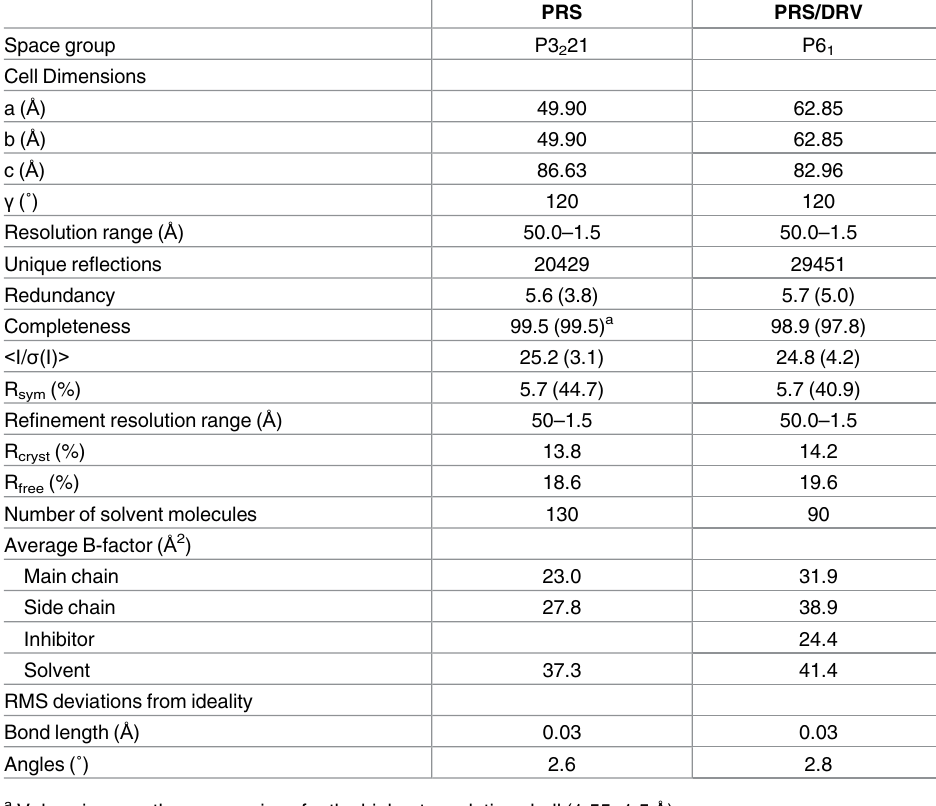
Table 1. Crystallographic Data Collection and Refinement